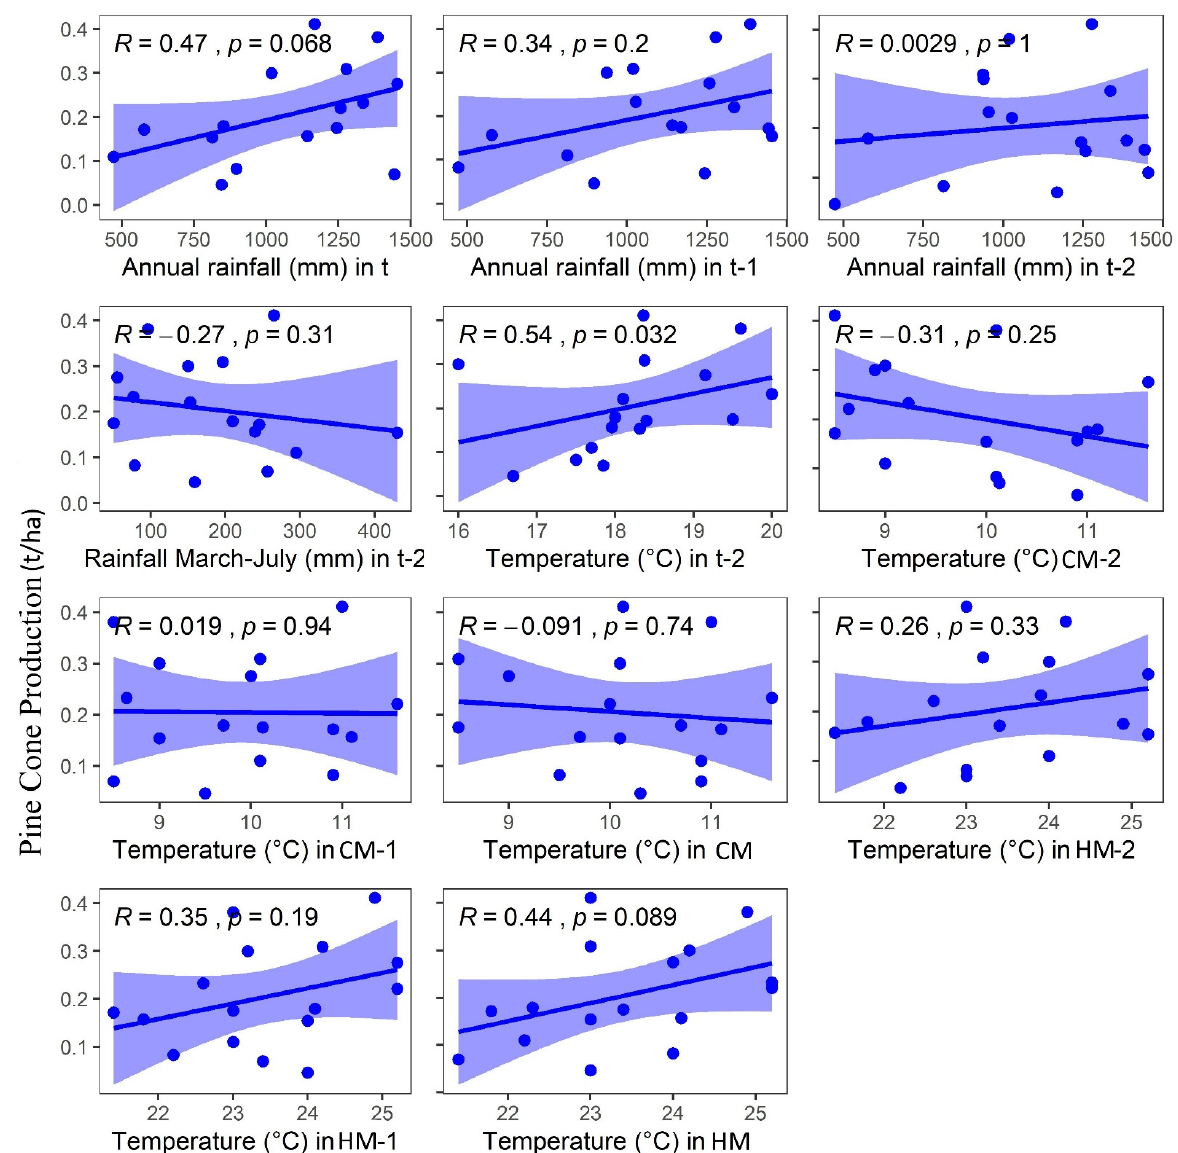
Figure 4. Summary of Pearson correlation between pine cone production and climatic variables in Lebanon. t—year of harvesting; t-1—one year before the year of harvesting; t-2—two years before the year of harvesting; CM—coldest months in the year of harvesting; CM-1—coldest months one year before the year of harvesting; CM-2—coldest months two years before the year of harvesting; HM—hottest months in the year of harvesting; HM-1—hottest months one year before the year of harvesting; HM-2—hottest months two years before the year of